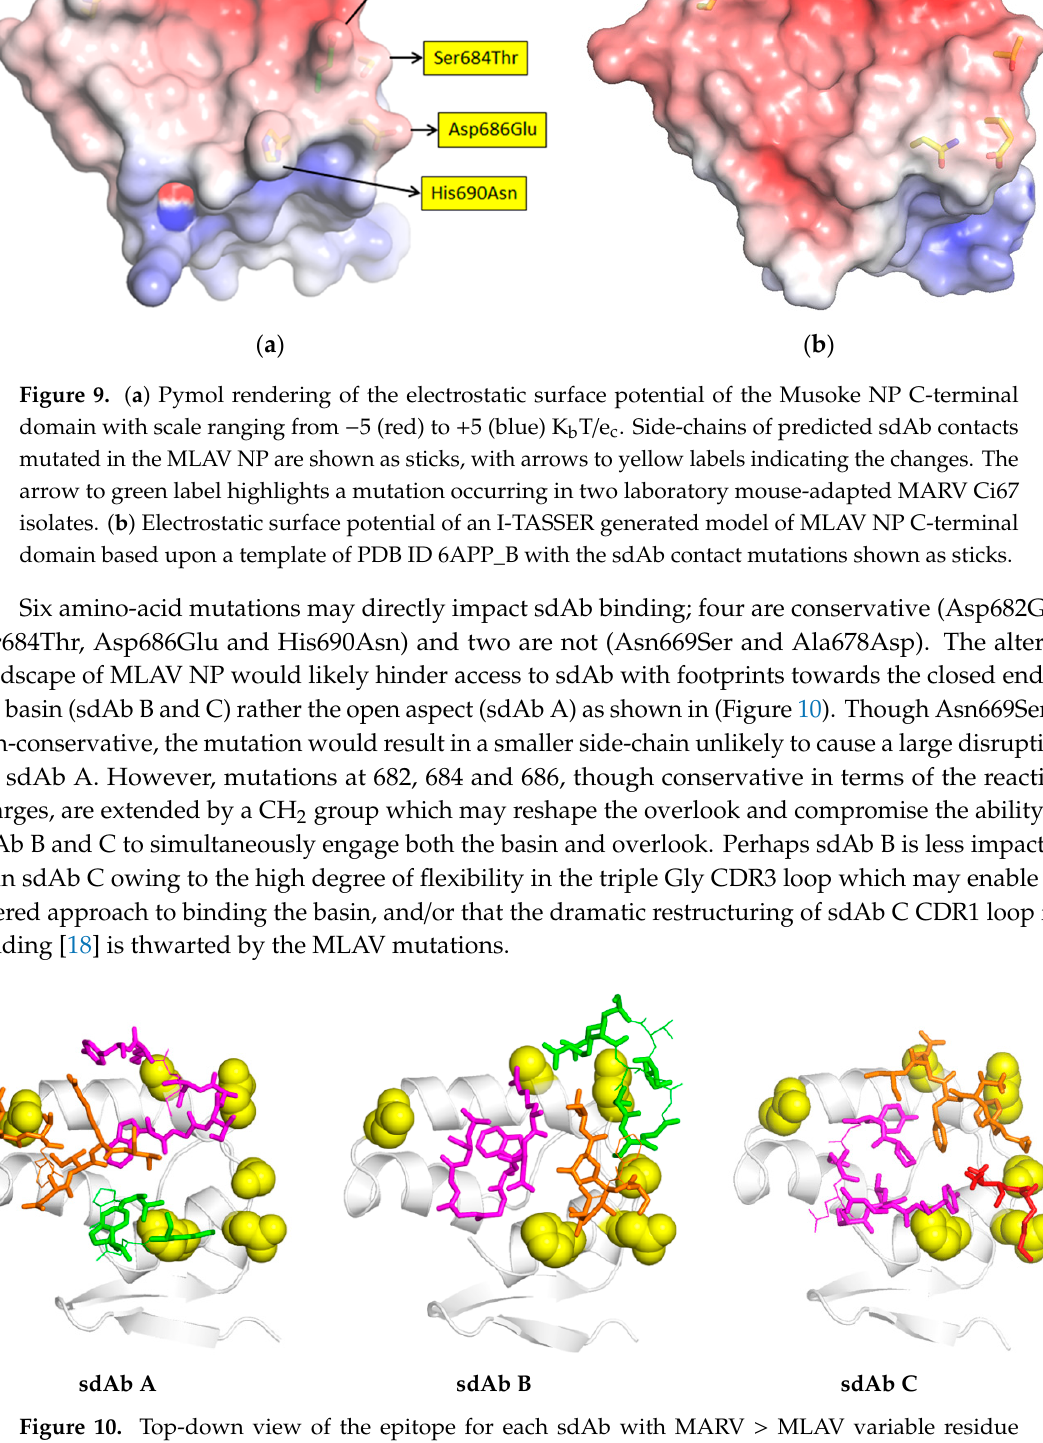
Figure 10. Top-down view of the epitope for each sdAb with MARV > MLAV variable residue side-chains predicted to be major contacts shown as yellow spheres. Only the CDR loops are shown as sticks (contacts) or lines (non-contacts) and colored; CDR1, orange; CDR2, green; CDR3, purple. In the sdAb C complex framework 1 (FR1) contacts are shown in red which for chains E and F involve Lys1 and Val2 though in chains A and B only involves Lys1 via non-bonded contacts to Glu687 and Asp686.